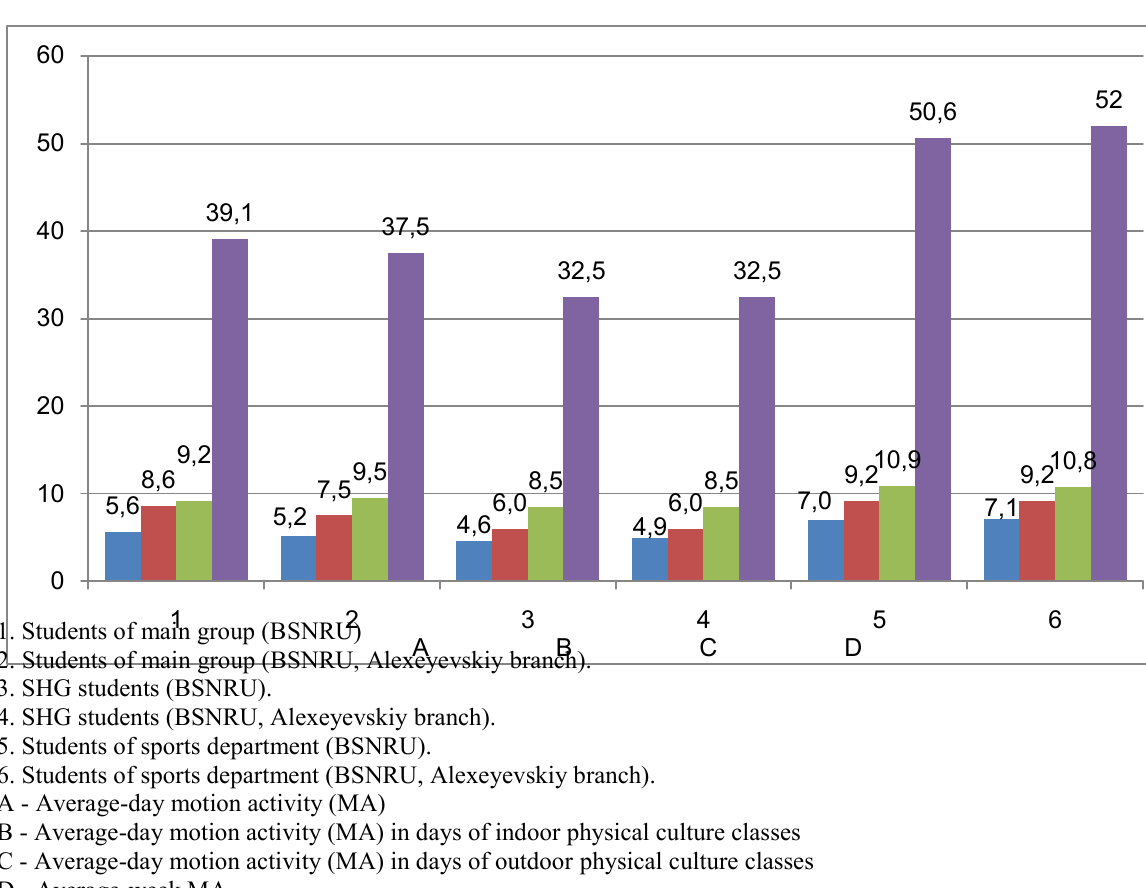
Fig.2 Motion activity (MA) of different groups students studying and living in urban environment (Belgorodskiy scientific research university) and in country environment (Belgorodskiy scientific research university, Alexeyevskiy